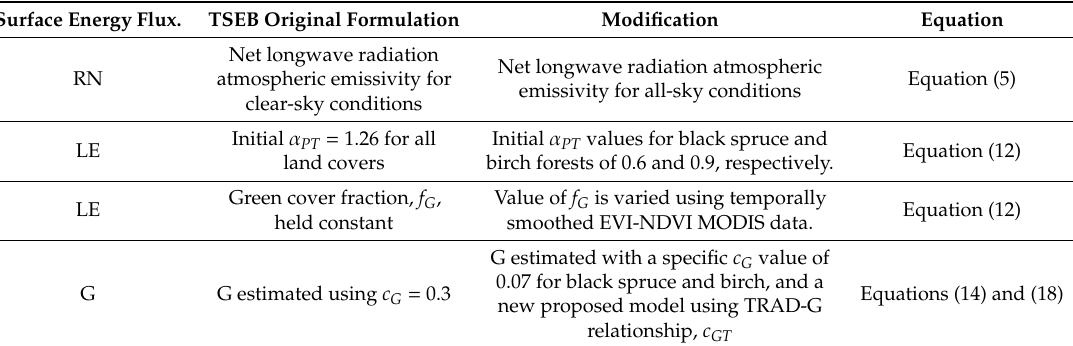
Table 1. TSEB model modifications for the boreal